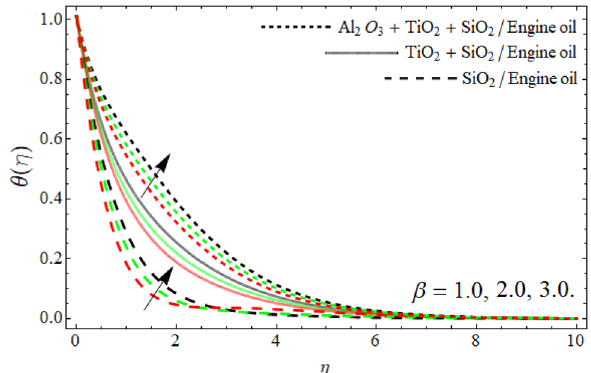
Figure 8. The energy θ(η) outlines versus ferrohydrodynamic interaction number β